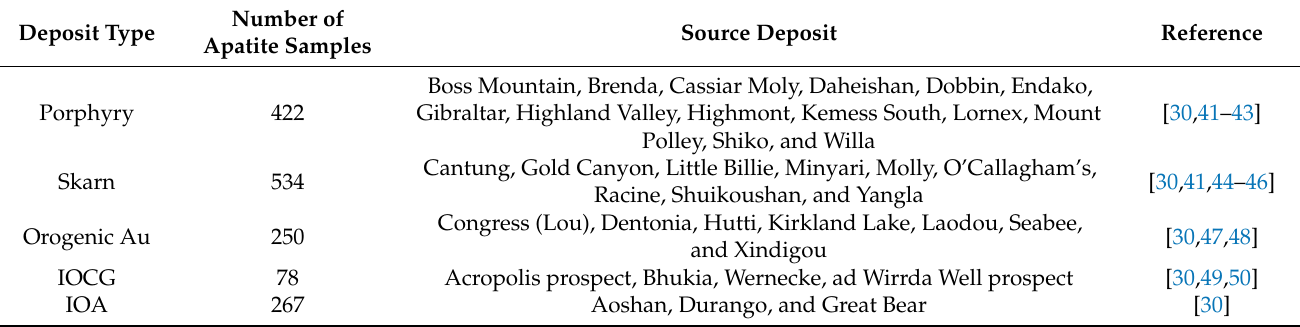
Table 1. Apatite trace element dataset used in this